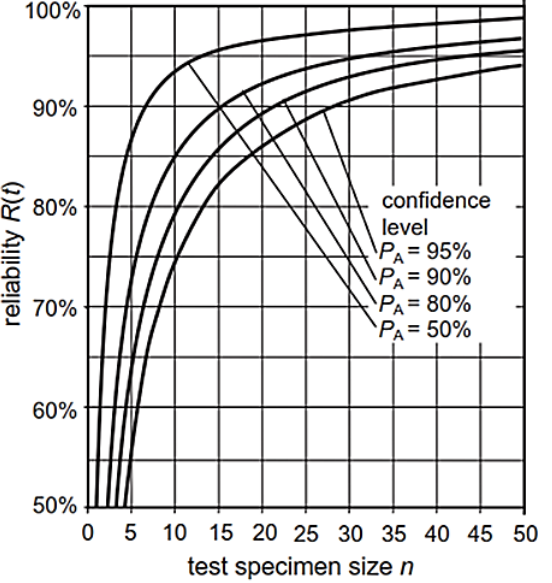
Figure 1. Minimal reliability R(t) as a function of the test specimen size n and the confidence level P A , if at the point in time t no failure has occurred